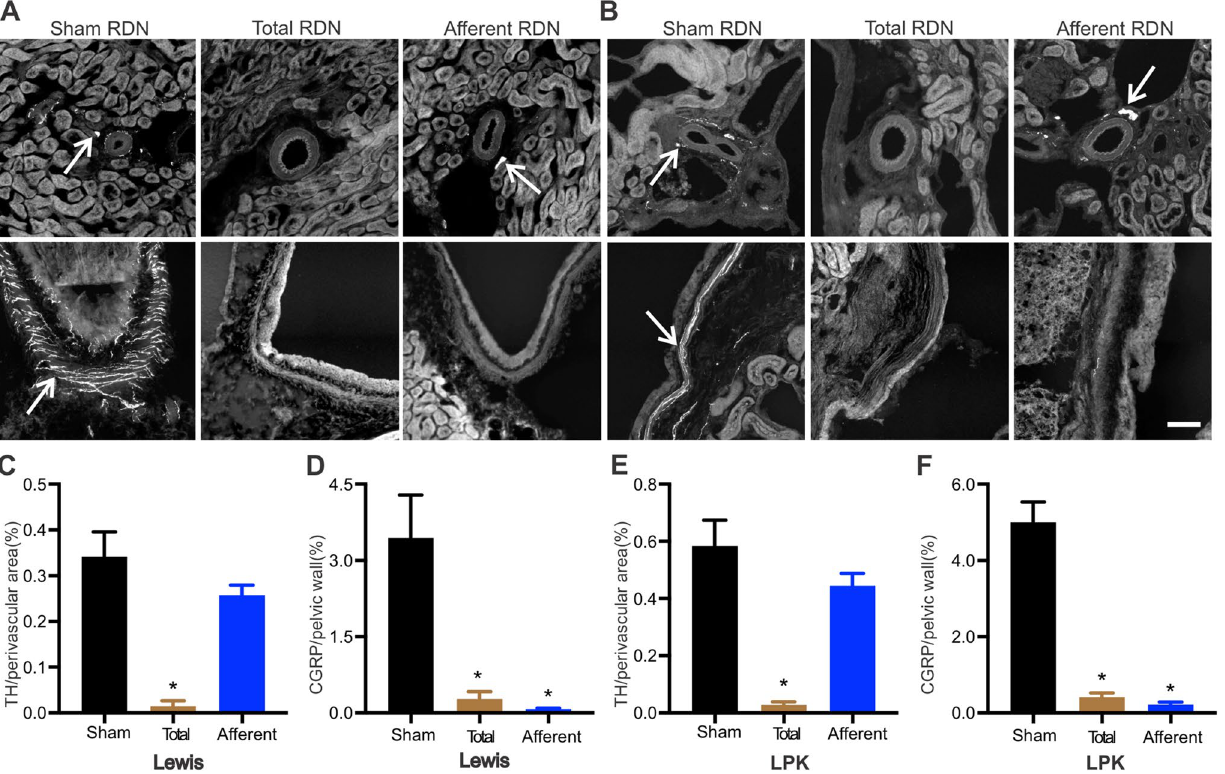
Figure 1. Validation of renal denervation (RDN) protocols determined using immunohistochemical assessment of tyrosine hydroxylase (TH) and calcitonin gene-related peptide (CGRP) innervation density one- week post-denervation as markers for sympathetic and sensory nerves respectively. Representative images of TH (top row) and CGRP (bottom row) staining in Lewis ( A ) and Lewis Polycystic Kidney (LPK; B ) rats after sham, total and afferent RDN, respectively. Arrow indicates positive staining, scale bar lower right panel = 100 µm for all images. Panels ( C – F ) present quantitative analysis of TH and CGRP innervation density staining. Data is expressed as mean ± SEM, *indicates P < 0.05 difference vs. sham RDN analysed using one-way ANOVA and Bonferroni’s post hoc analysis. n = 4–6, per treatment group per